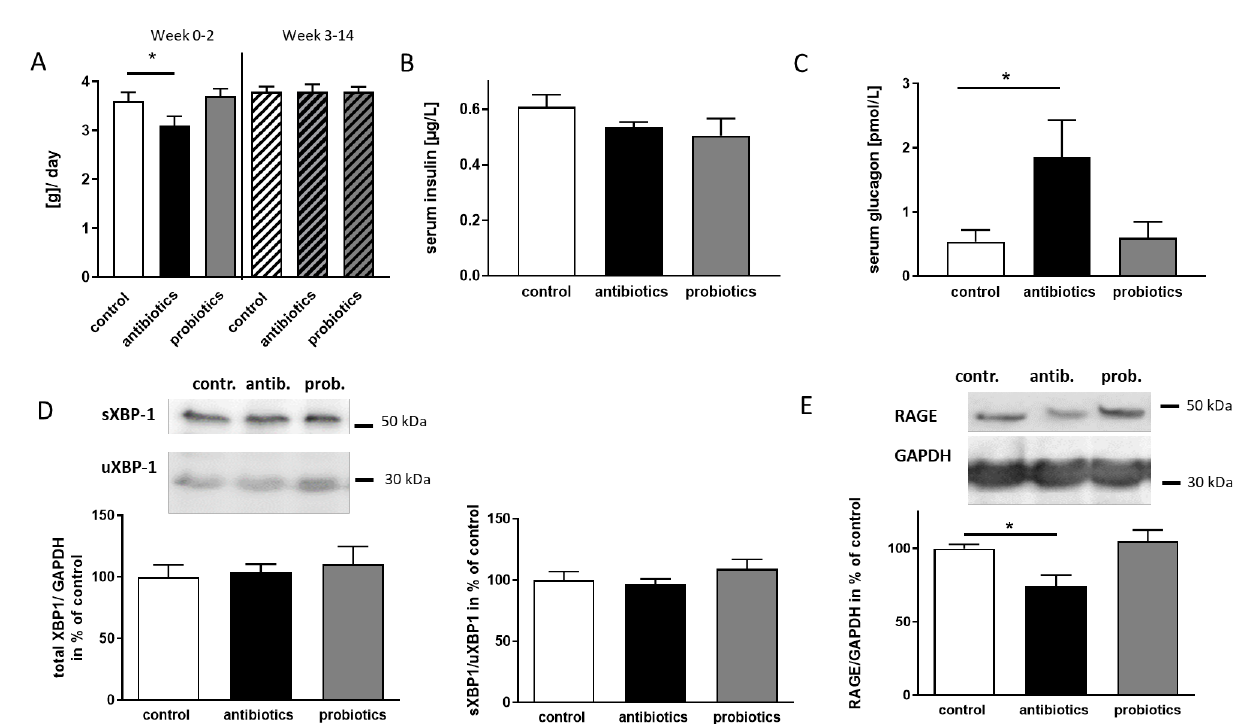
Figure 4. Effect of antibiotics on blood glucose homeostasis and insulin-dependent pathways. ( A ) Food consumption of the mice was measured twice a week. Columns without pattern show the food intake within the first two weeks, patterned columns show the food consumption within the weeks 3 to 14. ( B ) Serum insulin was measured by ELISA using 10 µL sample in duplicate. For glucagon ( C ) 25 µL were used in technical duplicates. ( D ) Splice variants of XBP-1 (S: spliced; u: unspliced) were quantified by Western blotting and ECL-based signal development due to appropriate HRP-labelled secondary antibody. ( E ) RAGE and GAPDH, which served as a loading control, were visualized as described ( n ≥ 5 per group for Western blots and ELISAs). Mean + SEM are presented. Statistics were performed with one-way ANOVA and Dunnett ’ s post-test (*, p < 0.05).